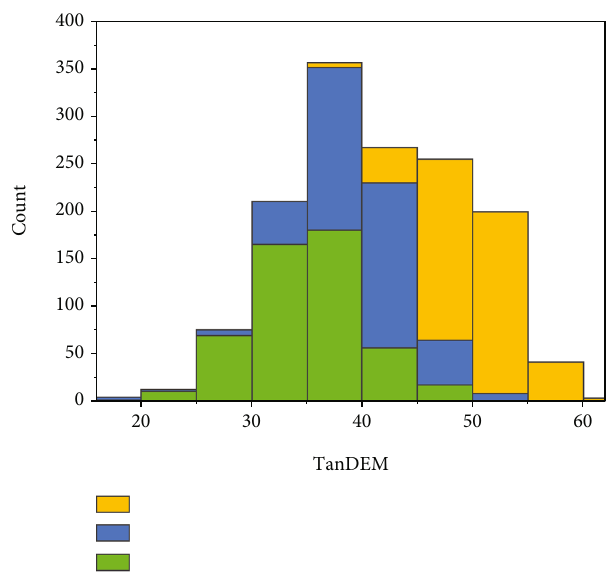
Figure 5: Comparison of logical